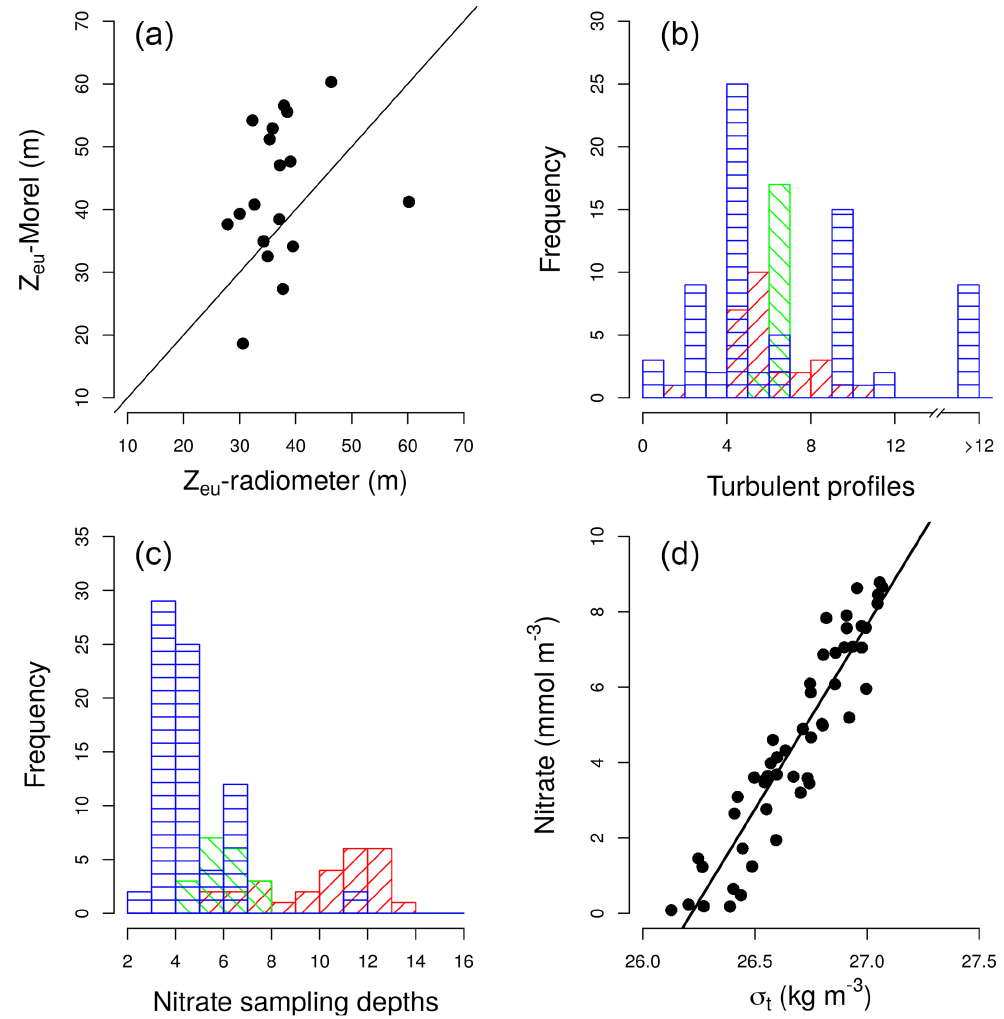
Figure A1. (a) Pair scatter plot representing the relationship between the euphotic zone depth ( Z eu ) computed using the Morel et al. (2007) equation and the data collected by a radiometer during the HERCULES cruises; the solid line represents 1 : 1 relationship. (b) Frequency histogram of the number of turbulence profiles deployed at each station and domain. (c) Frequency histograms of the number of samples collected for the determination of nitrate concentration at each station and domain: tropical and subtropical Atlantic Ocean (red), the Mediter- ranean (green), and the Galician coastal upwelling (blue). (d) Pair scatter plot representing the relationship between nitrate concentration and density built by using all samples collected during the NICANOR sampling